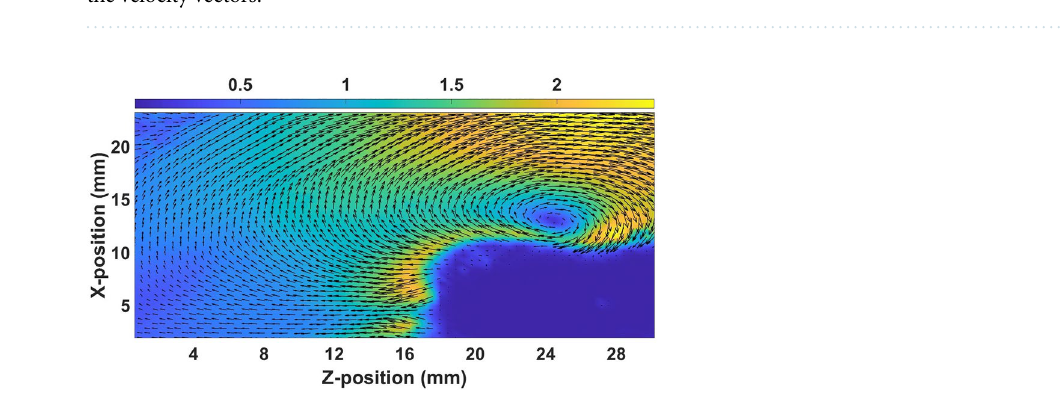
Figure 6. The magnitude of the vorticity ( 300 Pa, ( c ) 350 Pa and ( d ) 400 Pa of pulse valve for single layer flow. The arrows on the vorticity plot represent the velocity vectors.